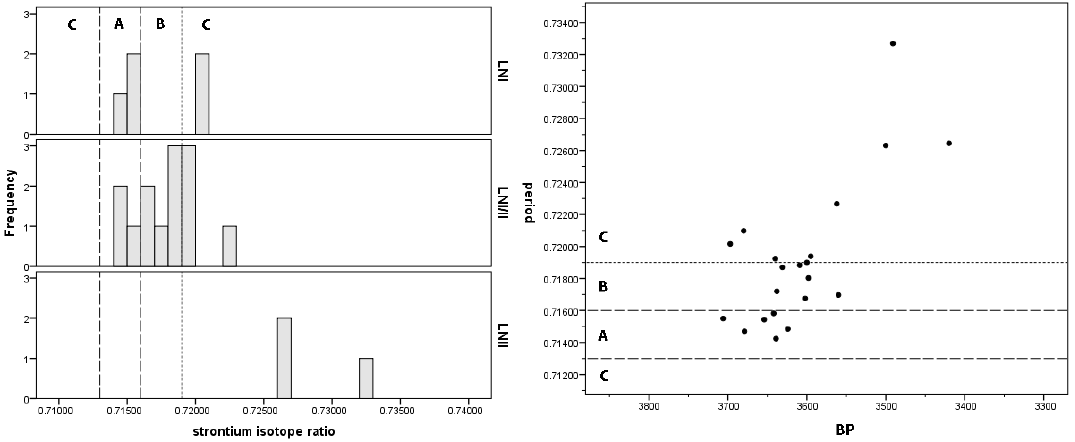
Figure 11. Strontium isotope ratios of the buried individuals in Falköping stad 5 in chronological order (histogram and a scatter plot). A: Local 87 Sr/ 86 Sr ratios, B: non-local/mixed 87 Sr/ 86 Sr ratios, C: non-local 87 Sr/ 86 Sr ratios, see text above. The local